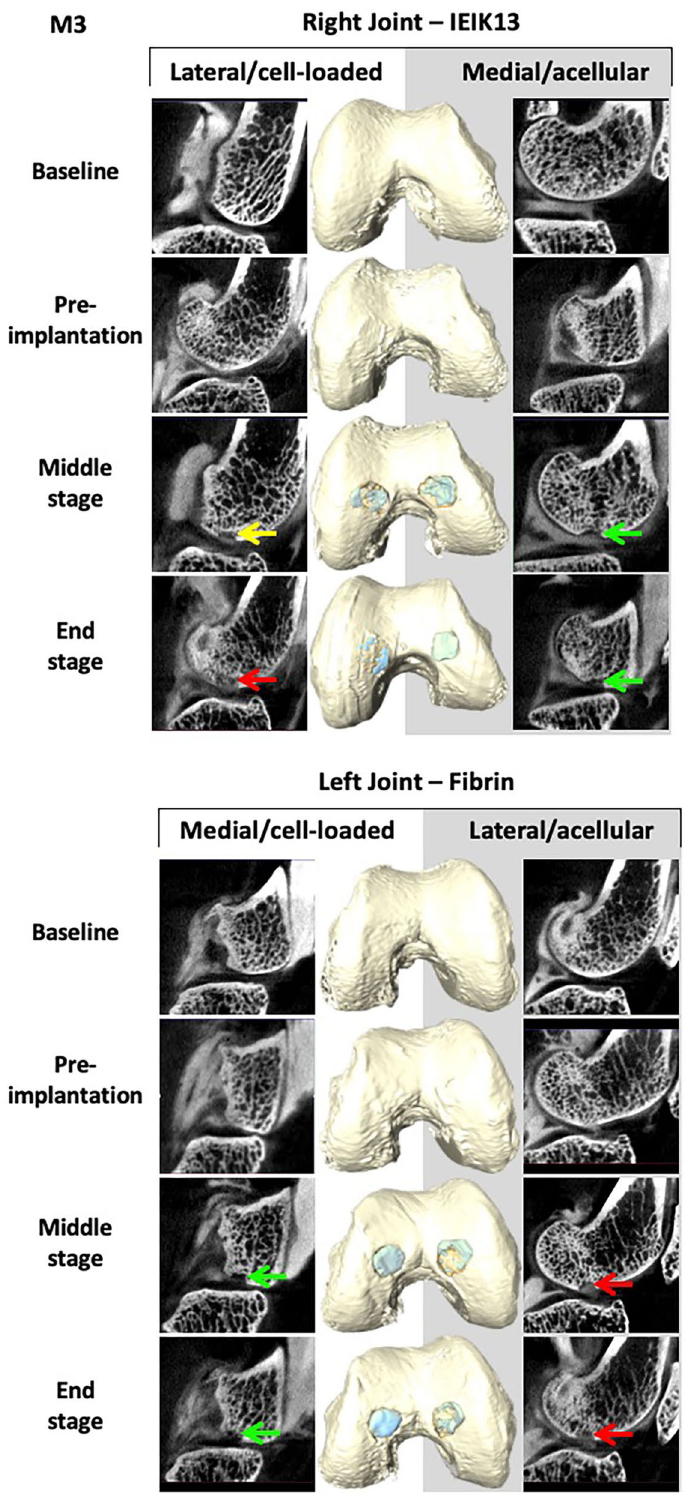
Figure 6. Non-invasive monitoring of IEIK13- and fibrin-based hydrogels implanted in M3 monkey. The hydrogels were loaded or not with cells, as indicated. The site of implantation in knee joint is specified. Examples of segmented CECT images (left and right panels) and 3D surface reconstruction (middle panel) corresponding to different stages of the study: 3 days before first surgery (baseline), 6 days before removal of the scar tissue and implantation (pre-implantation), 41 days after implantation (middle-stage) and 82 days after implantation (end- stage). The red arrows show complete filling of the defects by the contrast agent (observed as grey cloud) and the yellow arrow shows heterogeneous diffusion of the contrast agent. The green arrows show absence of contrast agent, indicating occupancy of the corresponding regions by the